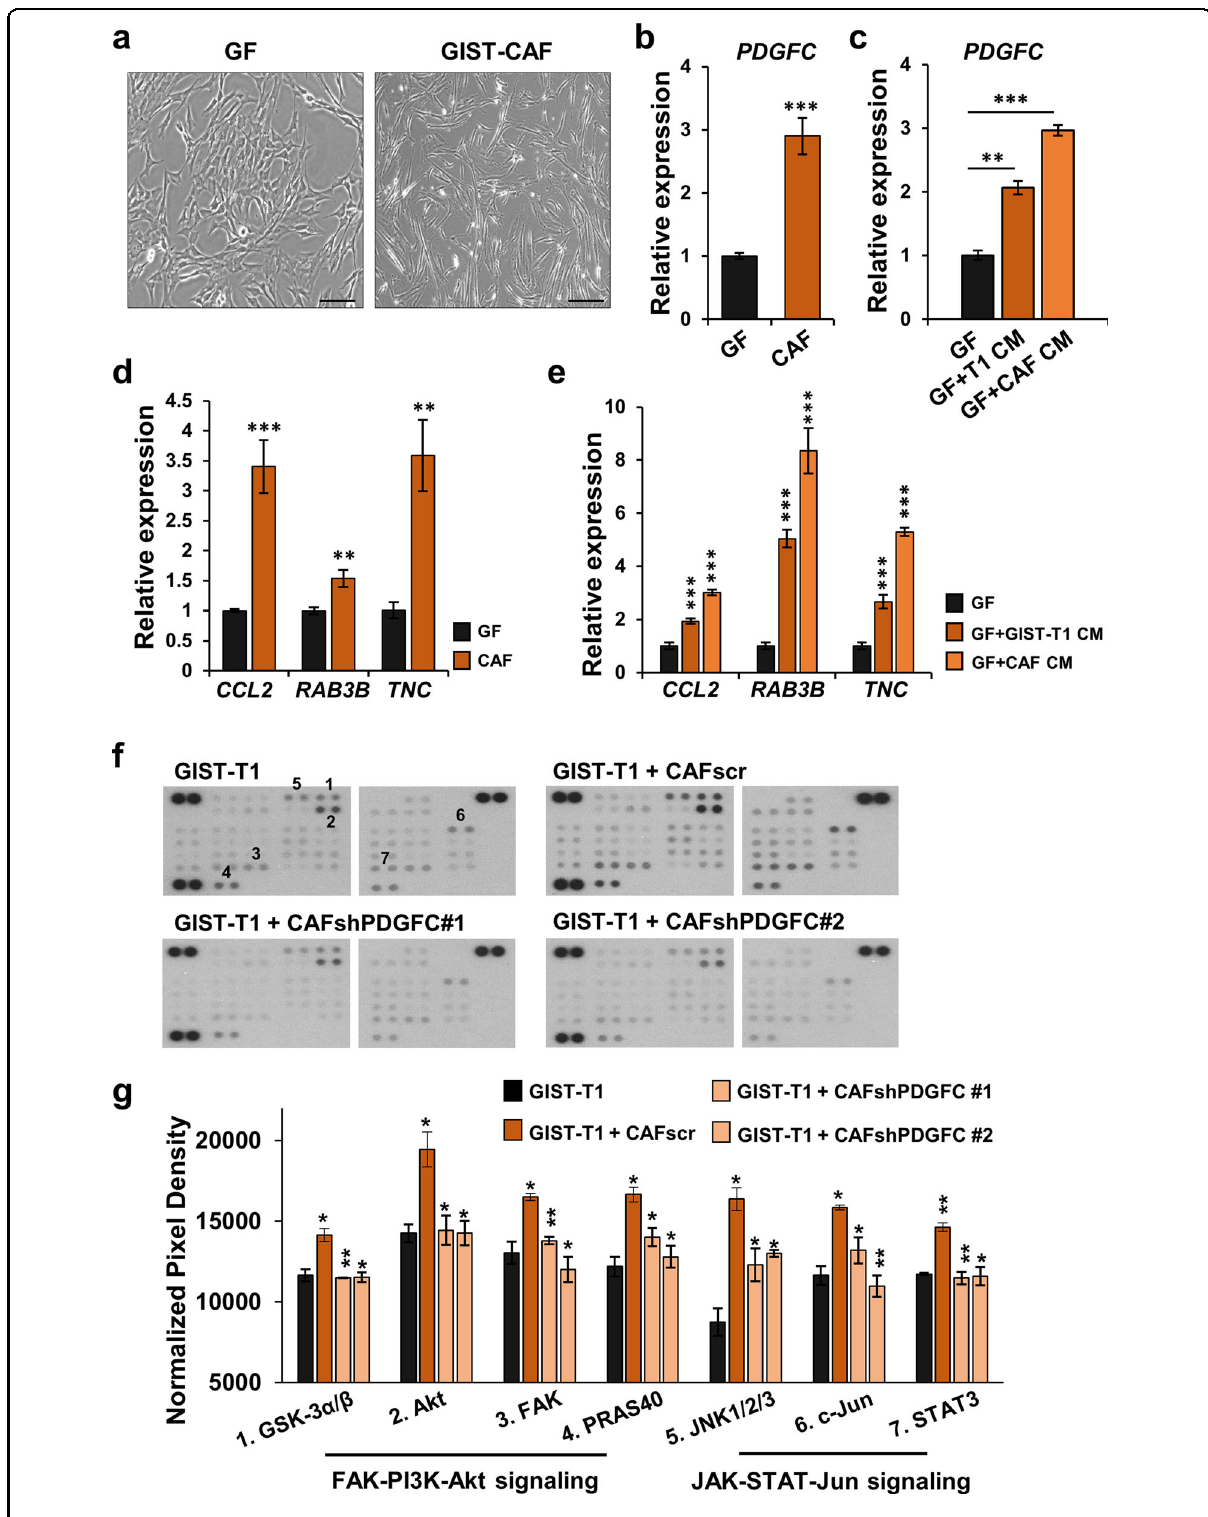
Fig. 1 (See legend on next